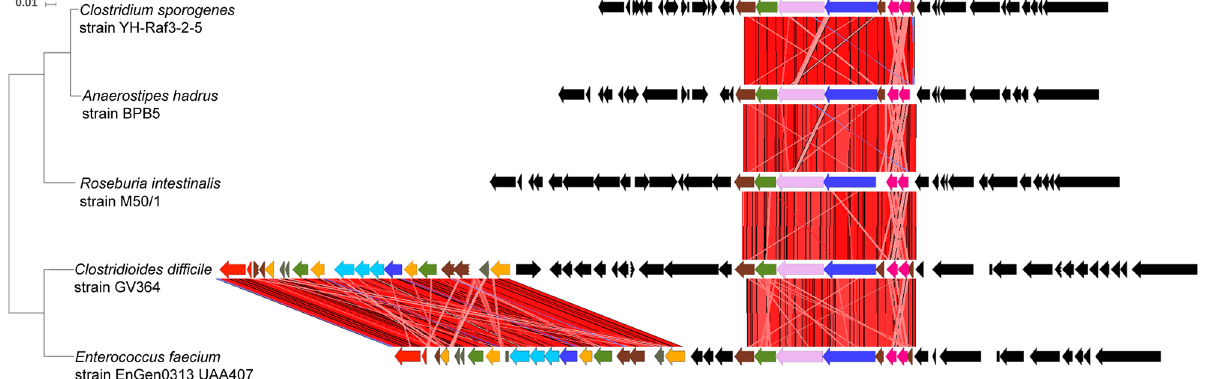
Figure 5. Human commensal microbiota may contribute to the acquisition of the 46 kb genomic island 1. The complete 46 kb GI1 is not present in any other microbial genome or plasmid sequence, but two gene segments (8.4 kb and 13.7 kb) within the island are found in other human enteric bacteria. The 8.4 kb gene segment is present in Enterococcus faecium EnGen0312 UAA407, Anaerostipes hadrus BPB5-Raf3-2-5, Clostridioides sporogenes YH-Raf3-2-5 and Roseburia intestinalis M50/1 strains (89.8%, 90.4%, 90.5% and 92.2% DNA sequence identity, respectively). E. faecium also harbors a 13.7 kb gene segment at 99% sequence identity. These two gene segments are found in E. faecium as part of a 36 kb genomic element. RT106 strains do not carry this 36 kb genomic element, but other C. difficile strains (VL0228 and 17-314-01071) strains have the identical 36